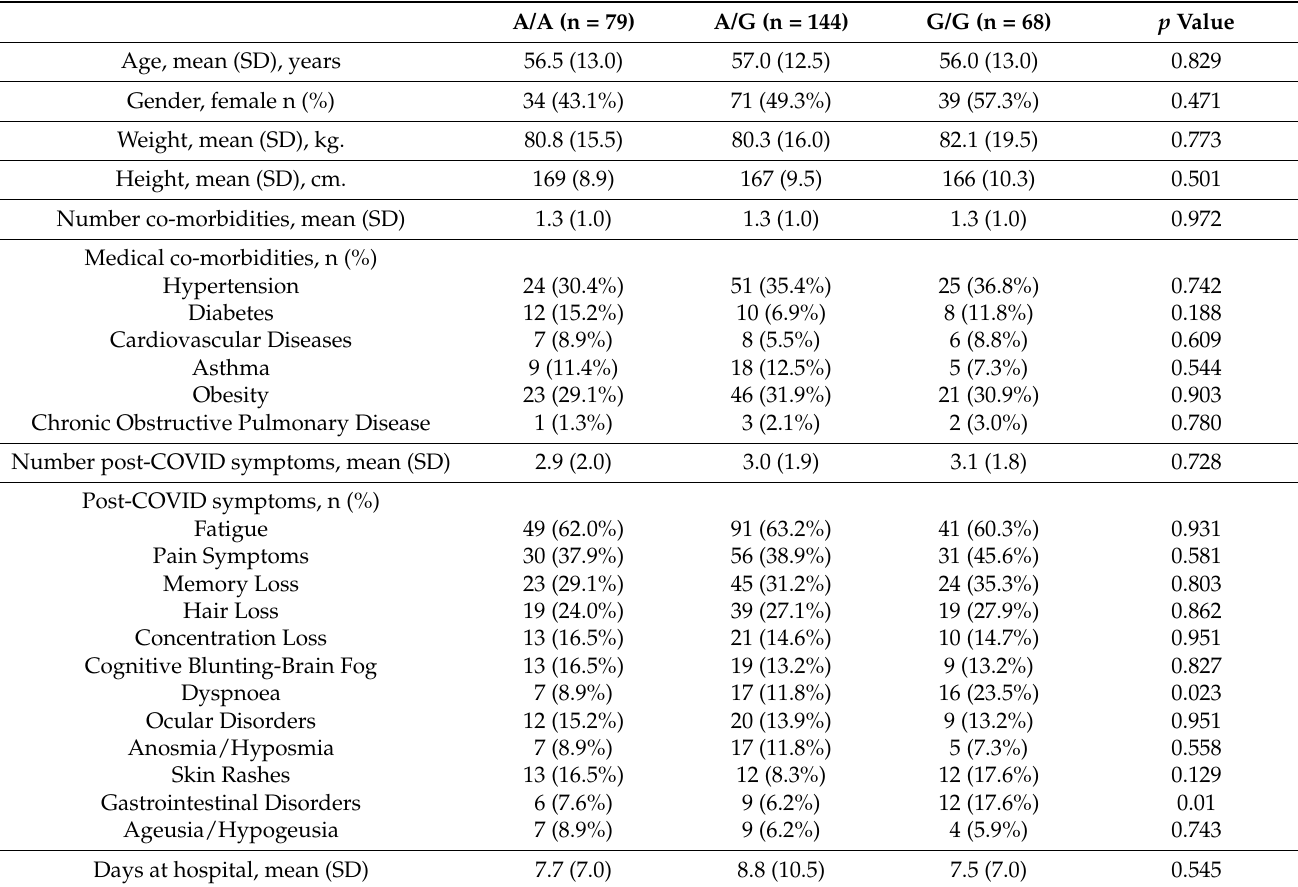
Table 5. Pre-Infection data and post-COVID symptoms according to the TMPRSS2 rs2070788 Poly- morphism Genotype (n =